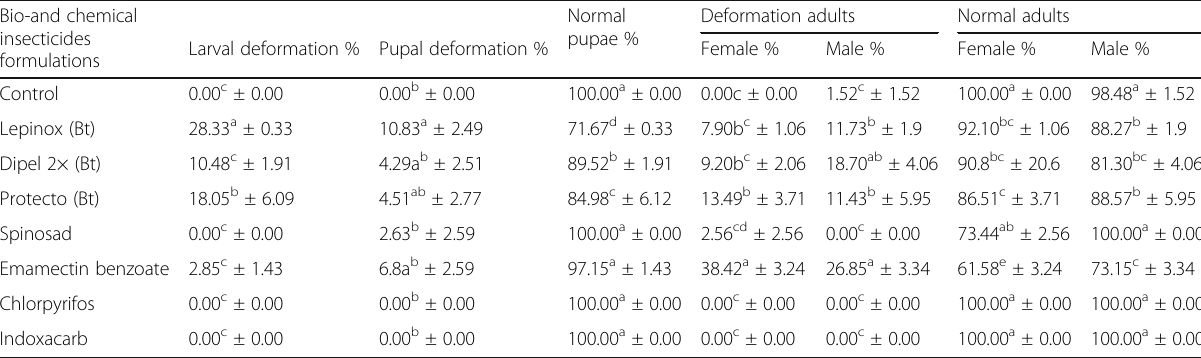
Table 5 Malformations % ± SE of Tuta absoluta after treated the 2nd instar larvae with LC 30 value of the tested bio-and chemical